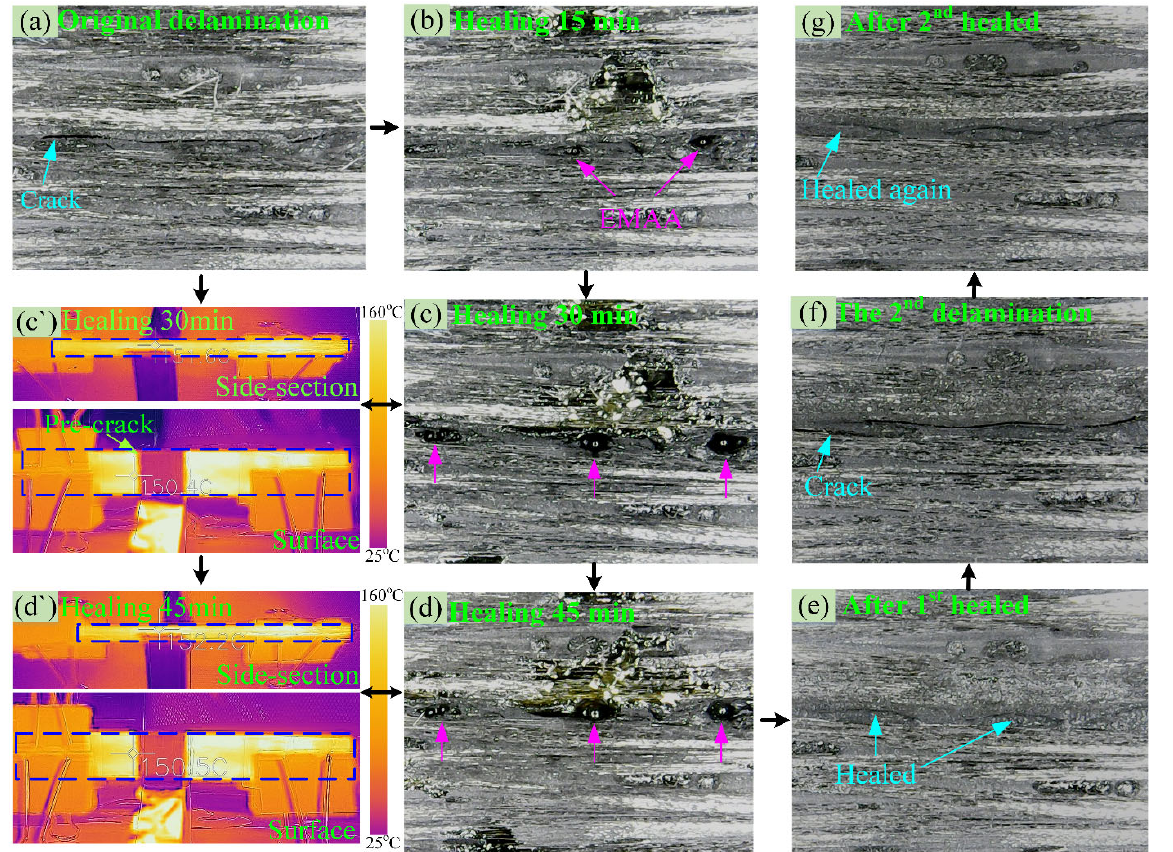
Figure 6. ( a – g ) Optical pictures of the crack from two delamination-healing cycles; ( c‘ , d‘ ) correspond- ing infrared temperature fields after healing 30 and 45 min by electrical